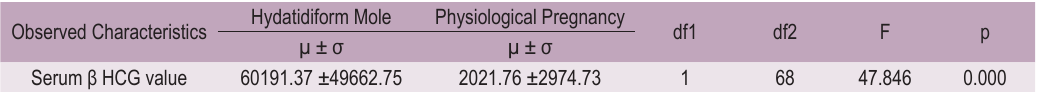
TABLE 1. Difference in average β HCG levels between groups